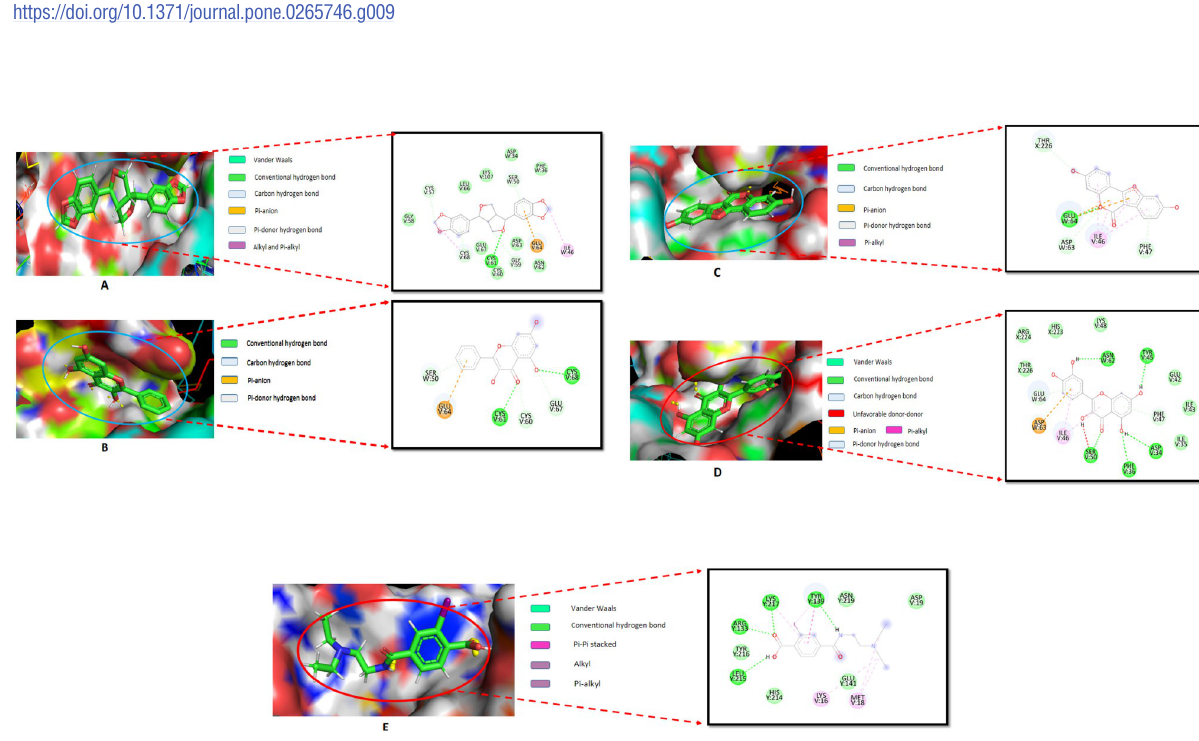
PLOS ONE | https://doi.org/10.1371/journal.pone.0265746 January 6, 2023 17 /